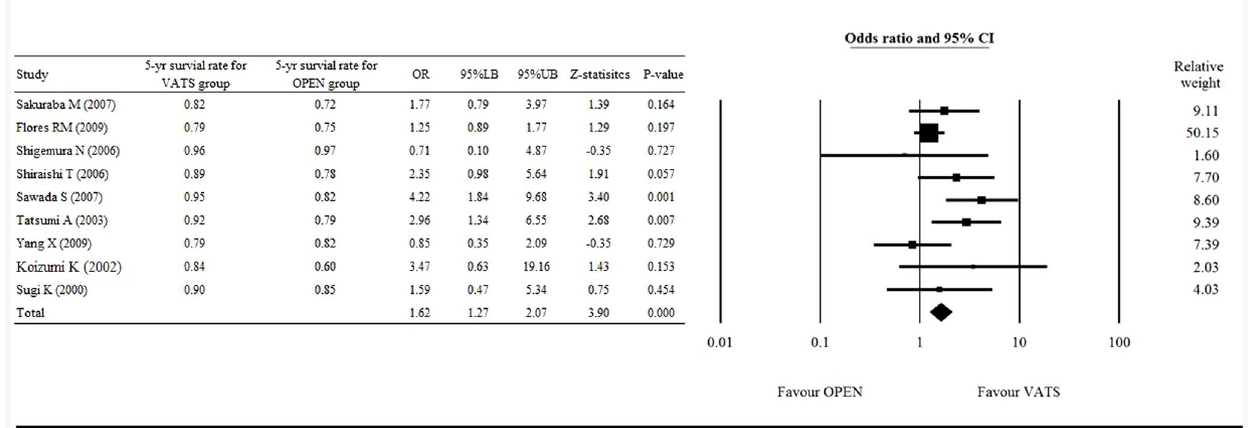
Figure 1. Forest plot of the 5-year survival rates of the VATS vs. open surgery groups. OR, odd ratio; LB, lower boundary; UB, upper boundary; CI, confidence interval.